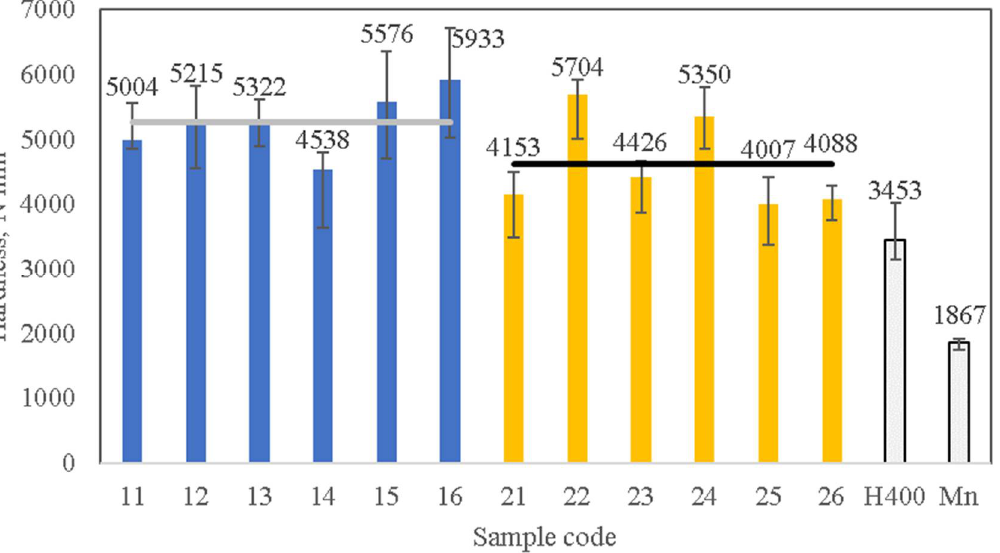
Figure 12. Universal macrohardness of tested materials determined by instrumented indentation method. Lines indicate the average values of each group (group 11–16, 5214; group 21–26, 4613 N · mm − 2 ). Color indicates the groups without (11–16), with (21–26) thermal treatment and reference materials (H400, Mn).